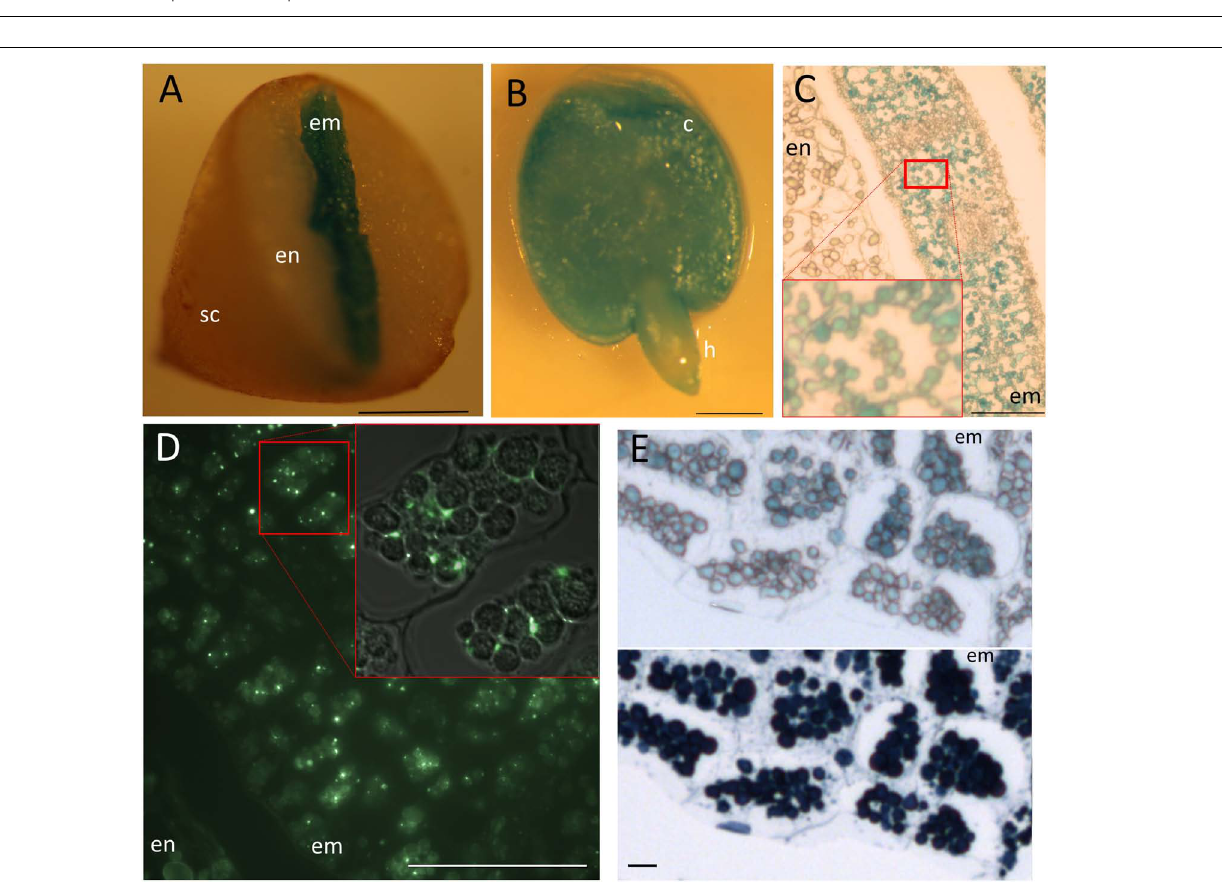
FIGURE 4 | Conservation of VIT1 sequence, expression and function. (A) Phylogenetic distribution of VIT1 orthologs in 18 different plant species from monocots, dicots and lower plants. Phylogeny was constructed by MEGA 7 with ML method for 1000 bootstraps using putative 34 VIT1 protein sequences. The red segment includes only dicots. Green segment includes only monocots except for one member of Vitis vinifera . The blue segment shows a diverged dicot member of E. grandis . Orange and cyan colors show algal and moss species, respectively. VIT1 from Arabidopsis thaliana is underlined. For details on analyzed sequences, refer to materials and method section. (B) Expression of VIT1 ortholog ( Glyma01g40600 ) in embryo tissues of soybean (Microarray data retrieved from www.seedgenenetwork.net). The picture illustrates the soybean ( Glycine max ) tissues: green, epidermis; orange vascular bundles; rest, parenchyma. (C) Impact of VIT1 orthologs in Fe distribution of rice ( Oryza sativa ) embryo. Unlike dicots, monocots such as rice do not have well defined organs. Longitudinal sections of whole rice embryos were obtained from either wild type or mutant rice ( VIT1 or VIT2 genes were either substantially knocked down or knocked out), stained by Perls/DAB (black color) and Fe distribution in the embryos were compared. Region with red line corresponds to provascular bundles (VB) in rice embryo. Red arrow heads point specific Fe accumulation pattern around provasculature. Bar is 0.1 mm.